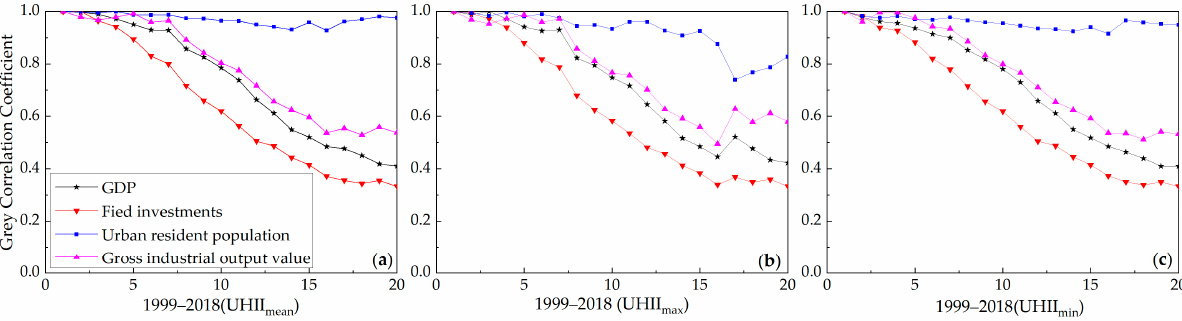
Figure 10. GRA of between the urbanization factors and UHII in Chongqing: ( a ) UHII mean ; ( b ) UHII max ; ( c ) UHII min .